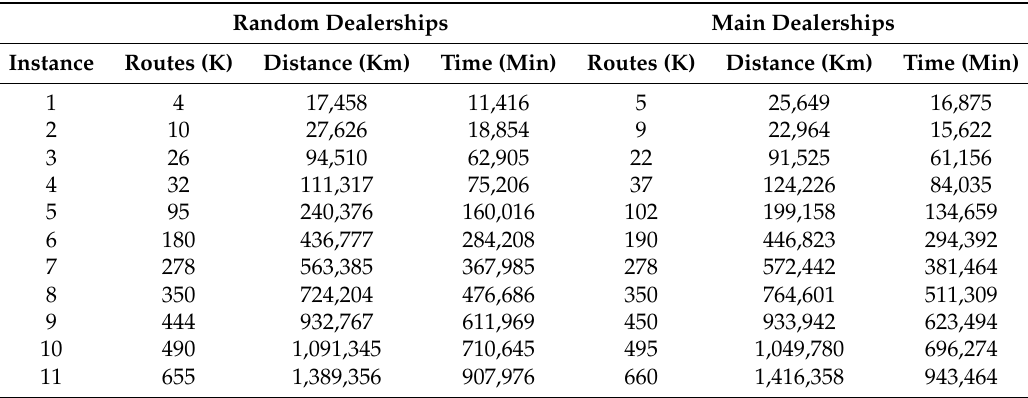
Table 7. Results of heterogeneous fleet (3,6,7,10 &